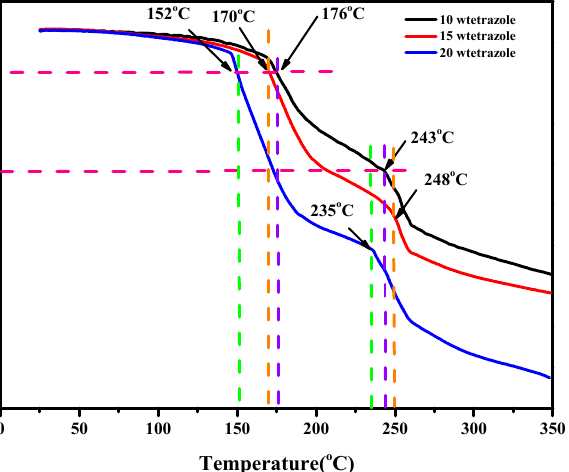
Figure 8. TGA of the different mass ratios additions of tetrazole in the 1-methylimidazole borane complex.